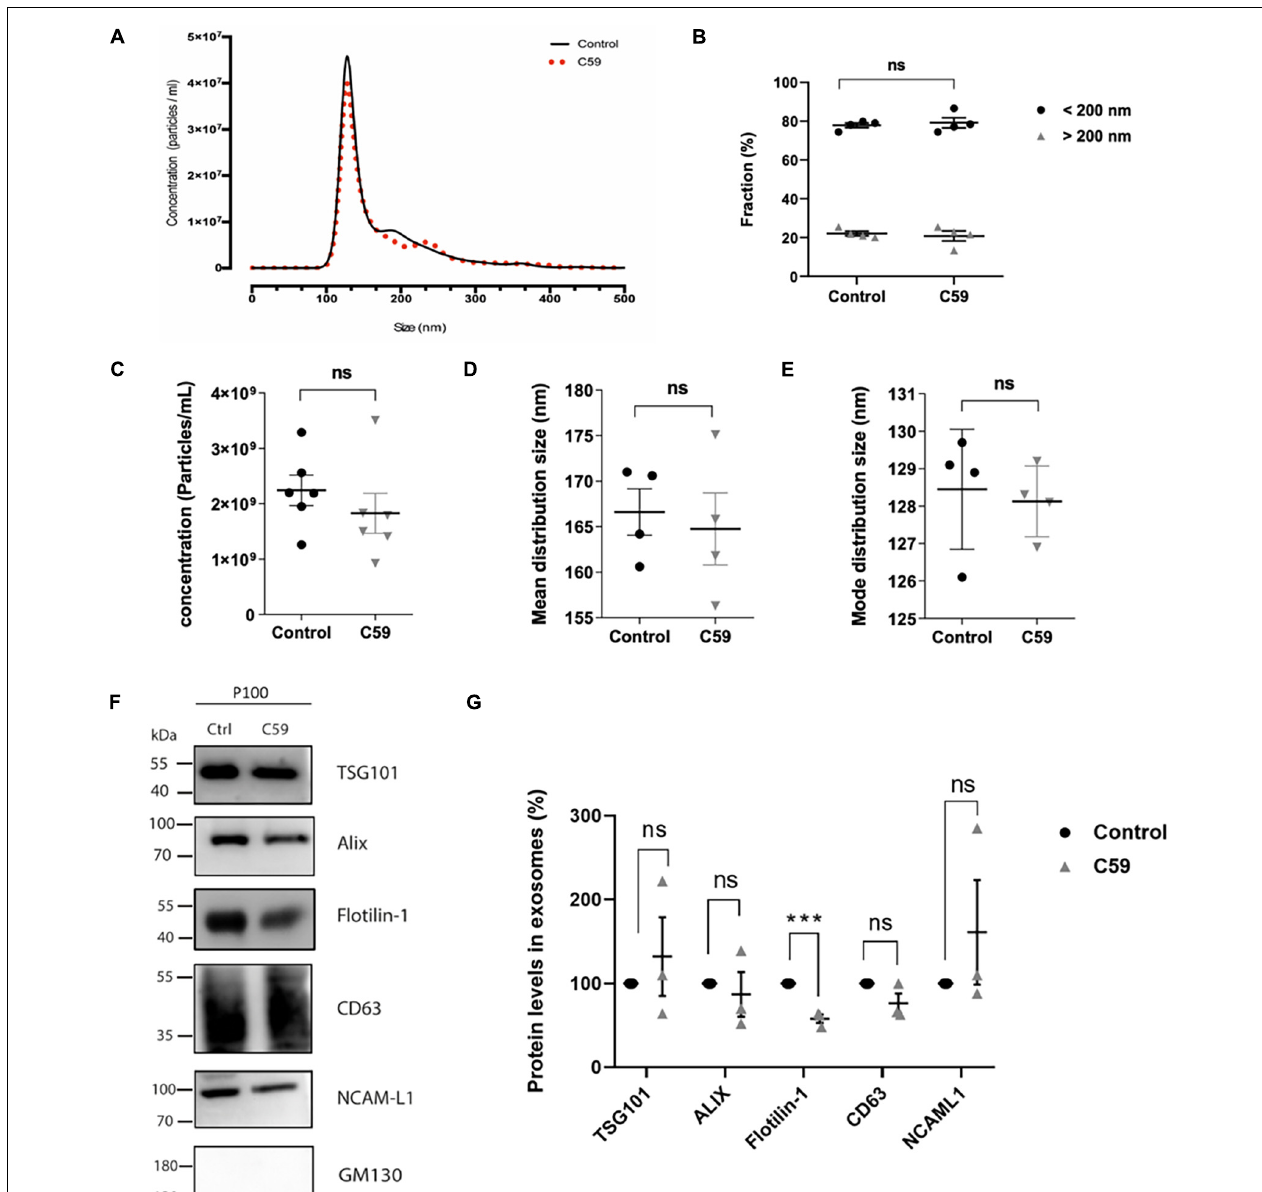
FIGURE 4 | Nanoparticle tracking analyses of exosomes secreted by control and Wnt-C59 treated HT-22 cells and the effect of Wnt-C59 on the content of exosomal markers in the P100 fraction. (A) Representative Nanoparticle tracking analyses show a mean peak for both control and Wnt-C59 samples. (B) Abundance analysis shows that 80% of the vesicles have a diameter of < 200 nm (Control: 77.88 ± 2.41%, Wnt-C59: 79.20 ± 5.22; n = 4) and a 20% > 200 nm (Control: 22.12 ± 2.41%, Wnt-C59: 20.83 ± 5.22; n = 4). (C) Concentration of particles. Shapiro–Wilk and KS tests showed that the data conformed to a normal distribution. Subsequently, the result of the Student unpaired t -test was p = 0.8272 with values of 2.3 × 10 9 ± 7.6 × 10 8 (control; n = 7) and 1.9 × 10 9 ± 8.3 × 10 8 (Wnt-C59; n = 7). (D) Mean distribution size of the total extracellular vesicles. Shapiro–Wilk and KS tests showed that the data conformed to a normal distribution. Subsequently, the result of the Student unpaired t -test was p = 0.7602 with values of 166.6 ± 2.5 (control; n = 7) and 164.8 ± 3.9 nm (Wnt-C59; n = 7). (E) Mode distribution size. As in (D) , values conform with a normal distribution. The student unpaired t -test result was p = 0.7824 with values of 128.5 ± 0.8 nm (control; n = 7) and 128.1 ± 0.4 nm (Wnt-C59; n = 7). n value means the number of independent cell culture preparations. (F) Representative western blot analysis of the protein content of TSG101, Alix, Flotillin-1, CD63, NCAM-L1 in P100 from control and C59 treated HT-22 cells. GM130 purity control is absent in the P100 fraction. (G) Relative protein expression levels of exosomal markers. The staining intensity of each band derived from control P100 was assigned a value of 100%, and the value obtained in the P100 from Wnt-C59 treatment was compared with its respective control. Flotillin-1 was the only exosomal marker whose expression level underwent a significant decrease in exosomes secreted by WntC59 treated HT-22 cells. TSG101 (Control: 100%, Wnt-C59: 132 ± 81.3%; n = 3; p = 0.700); Alix (Control: 100%, Wnt-C59: 87 ± 45.9%; n = 3; p = 0.6496); Flotillin-1 (Control: 100%, Wnt-C59: 58 ± 8.7%; n = 3; p = 0.0011); CD63 (100%, Wnt-C59: 76.3 ± 20.6; n = 3; p = 0.0952); NCAM-L1 (Control: 100%, Wnt-C59: 161 ± 157.9; n = 3; p = 0.3831). Mann–Whitney non-parametric t -student test (ns, not significant; *** p < 0.005).